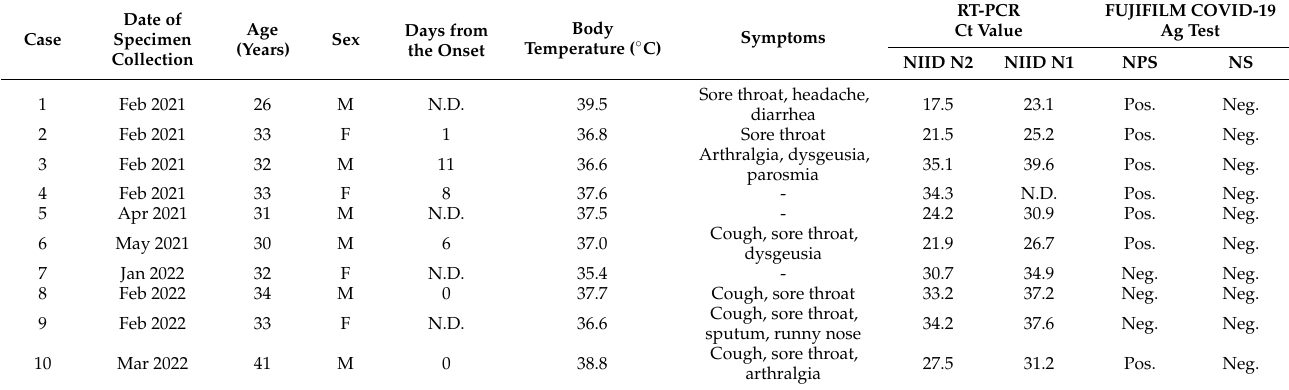
Table 4. Detailed data of 10 cases with false-negative results to reference